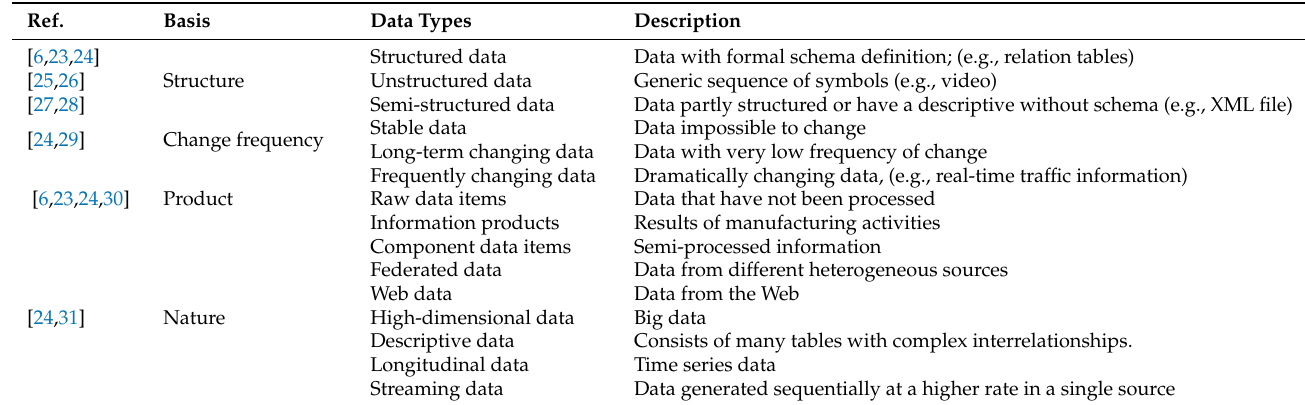
Table 1. Classifications for